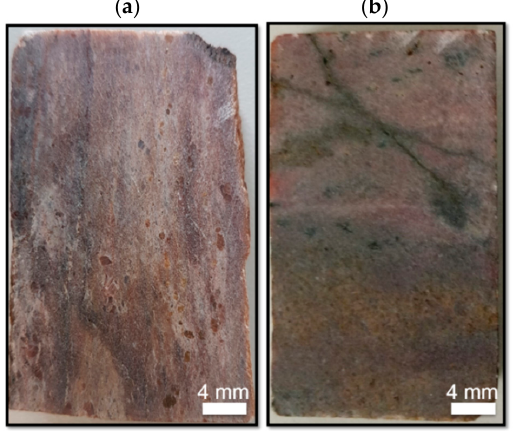
Figure 1. RGB images of the surface from the 40 × 20 mm 2 large rock pieces from the rare earth element (REE) deposits: ( a ) Epembe (NA-RZ-05); ( b ) Lofdal Farm (NA-RB-02).